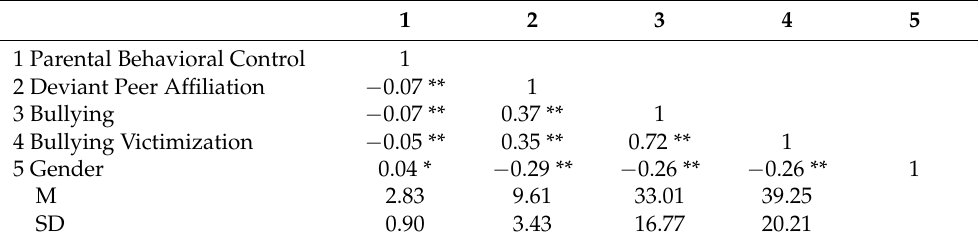
Table 2. Descriptive statistics and correlations for bullying, victimization, deviant peer affiliation, and parental behavioral control ( n = 3799).